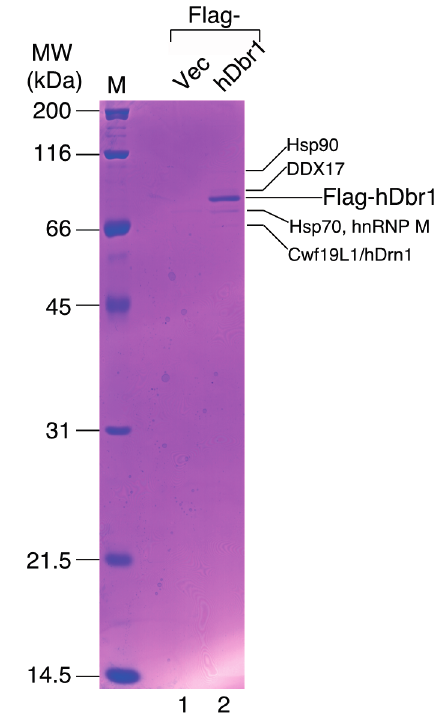
Figure 2. Identification of the proteins interacting with hDbr1 by MALDI-TOF mass spectrometry. Immunoprecipitation of the hDbr1 complexes with an antibody against Flag tag (M2; Sigma, St. Louis, MO, USA) from HEK293T cell extracts overexpressing Flag-hDbr1 (lane 2). The whole-cell extract prepared from the Flag-pcDNA3-transfected cells was used as a control (Flag-Vec, lane 1). Proteins were separated by 12.5% SDS-PAGE and visualized by Coomassie Brilliant Blue staining. The proteins identified by MALDI-TOF mass spectrometry are indicated by their names. The positions of the size marker proteins are indicated by their sizes (kDa) on the